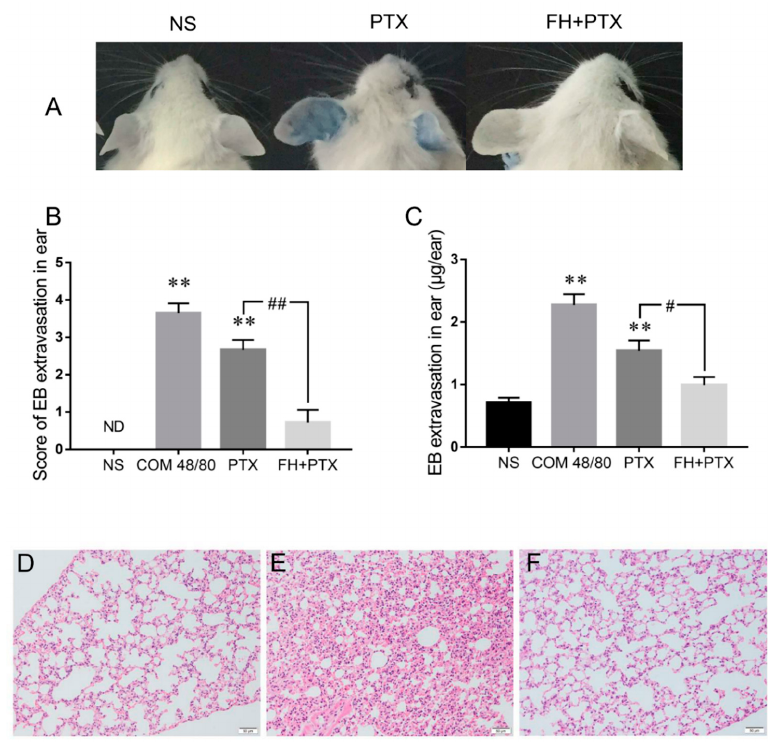
Figure 5. The inhibitory effect of FH on PTX injection-induced vascular leakage in mice ear and on lung inflammation. ( A ) The blue color in mice ears that received treatment of NS, PTX (16 mg/kg),